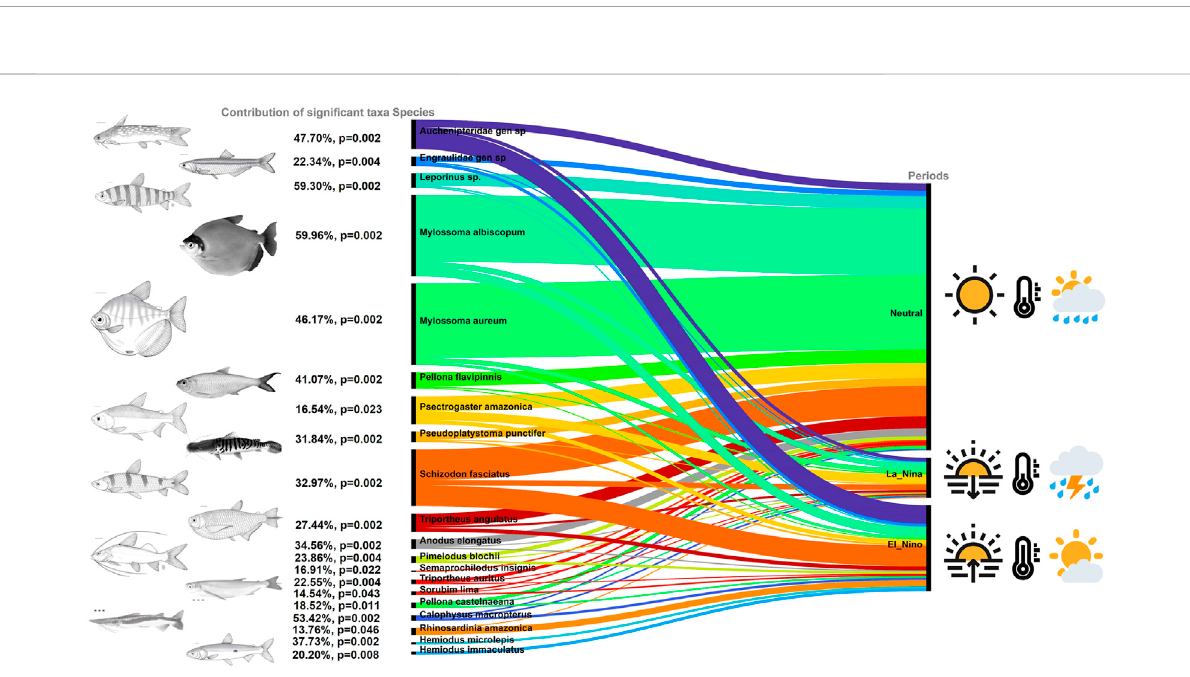
FIGURE 4 SummaryofresultsfromindividualmultivariateGLMforperiodeffectsonlarvalassemblagecomposition,thepercentcontributionofunivariate model deviance of signi fi cant taxa to the parameter deviance in the multivariate model, and the associated p -value. Figures of the fi sh were adapted from Galvis et al. (2006) and Santos et al.